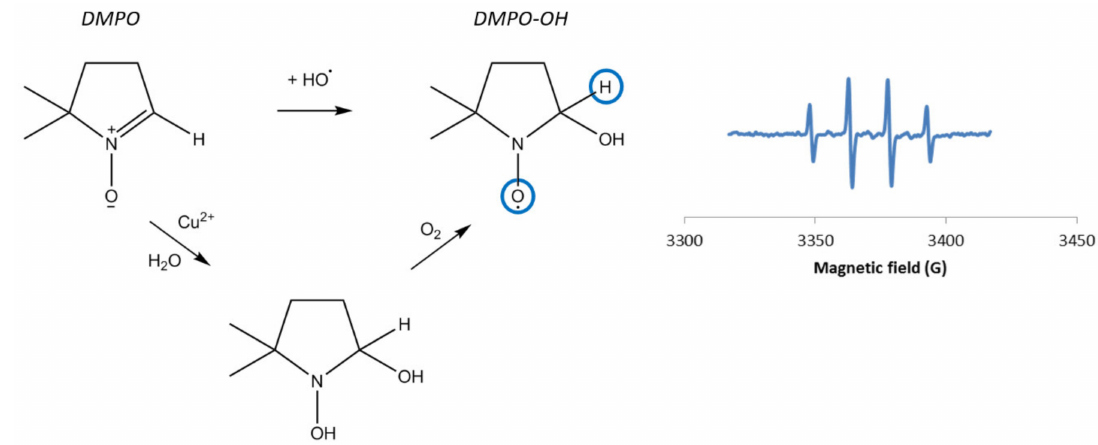
Figure 2. Left: Hydroxylation of DMPO into DMPO–OH and mechanism of nucleophilic addition of water on DMPO in the presence of Cu, also leading to the DMPO–OH adduct, as described by Burkitt et al. [15]; Right: Typical EPR spectrum of DMPO–OH